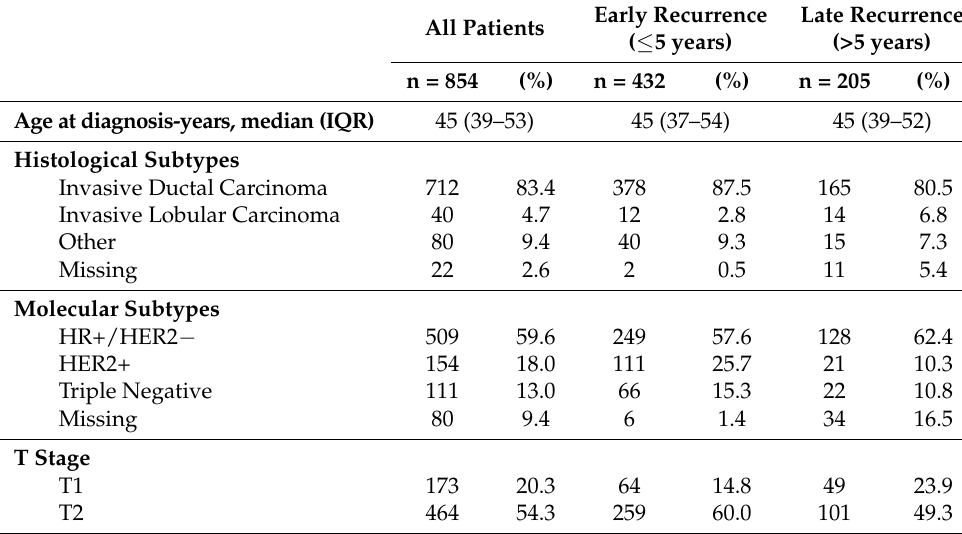
Table 1. Baseline characteristics of all